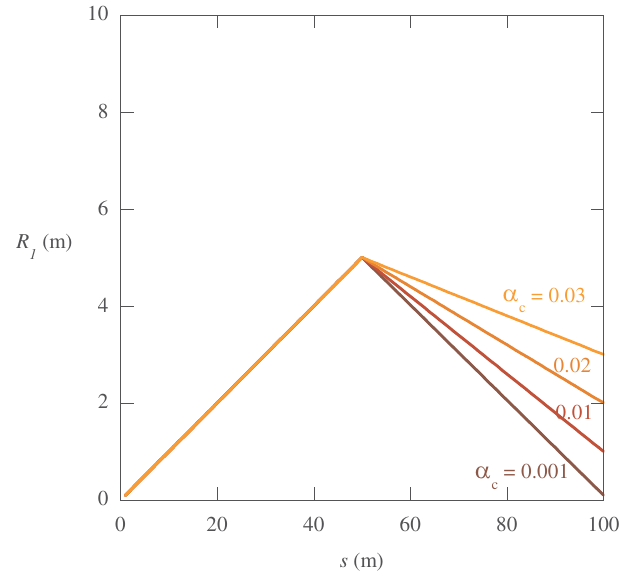
FIG. 6. (Color) Function R different values of (cid:1) lighter colors). are obtained. Figure 6 shows the R for four different values of (cid:1)